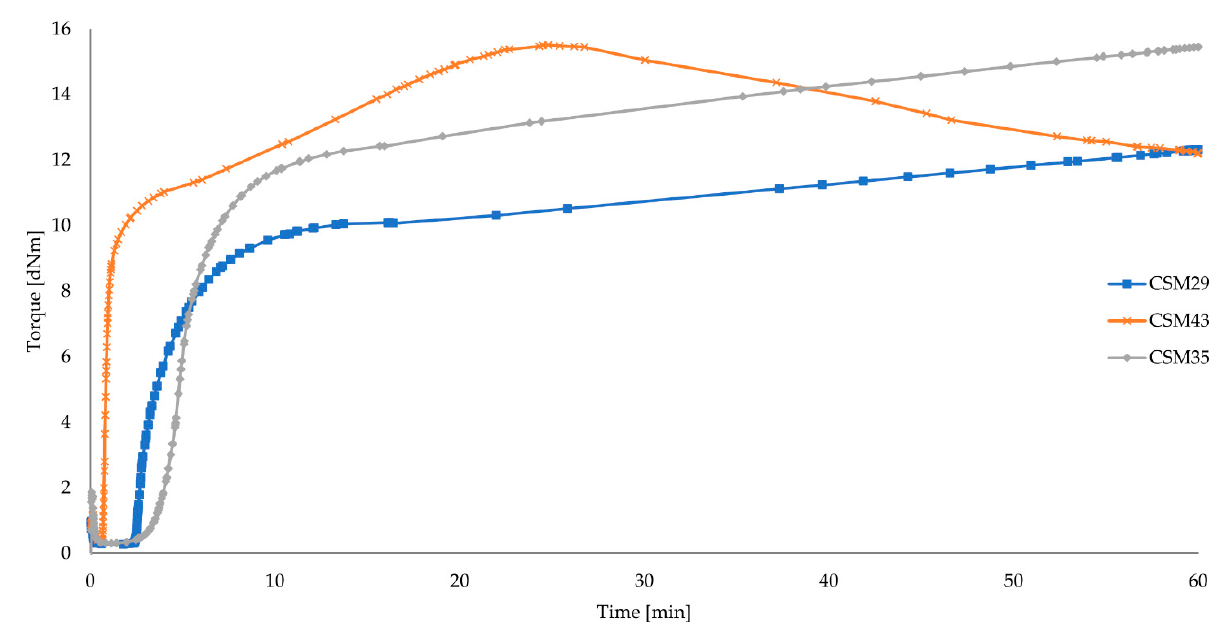
Figure 2. Vulcametric kinetics of chlorosulfonated polyethylene cross-linked with iron(II,III) oxide (3 phr of Fe 3 O 4 ).